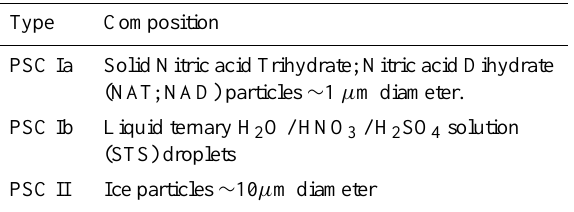
Table 2. Different types of Polar Stratospheric Clouds (PSCs) ac-